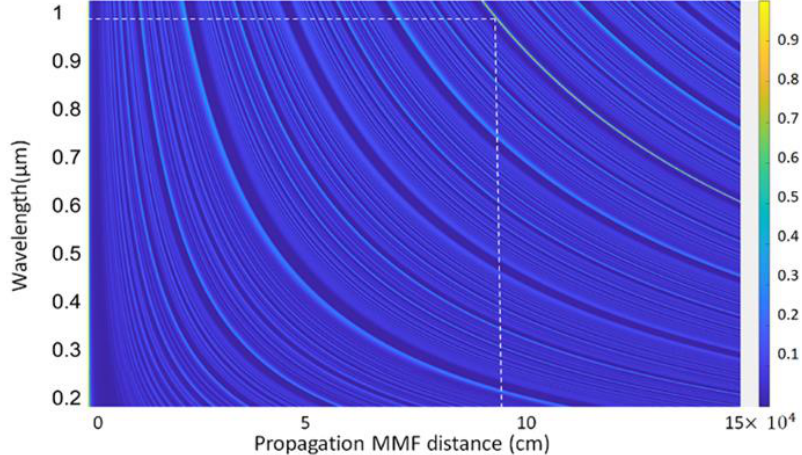
Figure 2. Coupling efficiency of the propagating distance of the CSF segment.